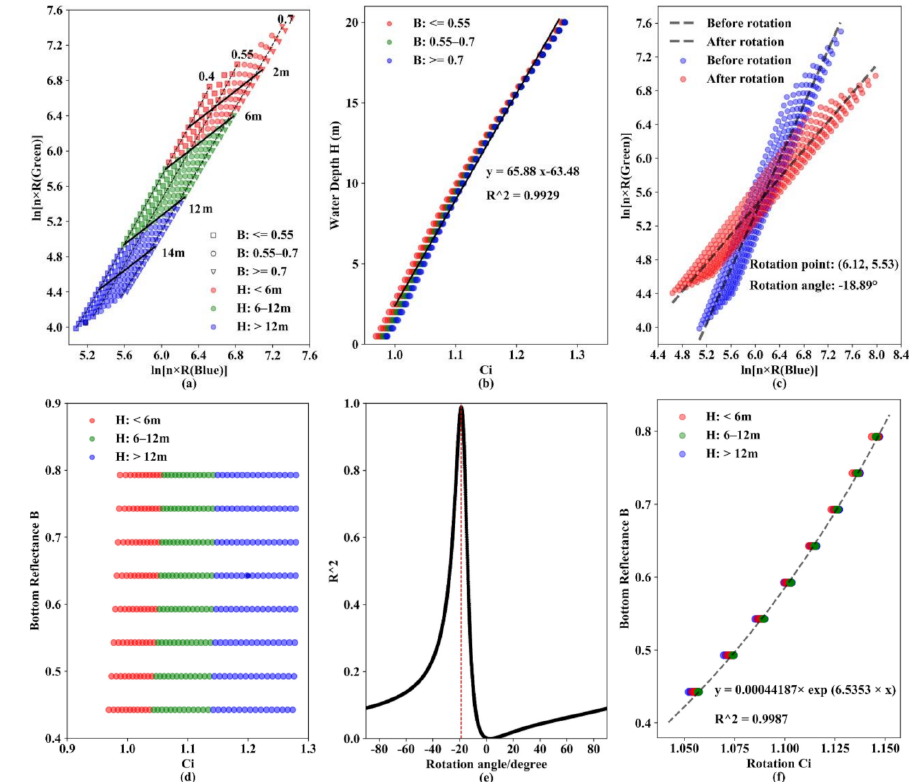
Figure 1. ( a ) Hydrolight simulation reflectance of blue–green bands. Different colors represent different water depths, and different shapes represent different bottom reflectance. Black straight lines represent the water depth contours, and black dotted lines represent the bottom reflectance contours. ( b ) Fitting curve of C i and the corresponding water depth, H . ( c ) Scattered points in ( a ) before and after a clockwise rotation of 18.89 ◦ ( − 18.89 ◦ ) to , C (cid:48) bottom reflectance occurs. ( d ) Relationship between C i and the bottom reflectance before rotation. ( e ) Relationship between R 2 and rotation angle during rotation (R 2 : the correlation coefficient between C i and B ). ( f ) Exponential fitting curve of C (cid:48) and bottom reflectance, B